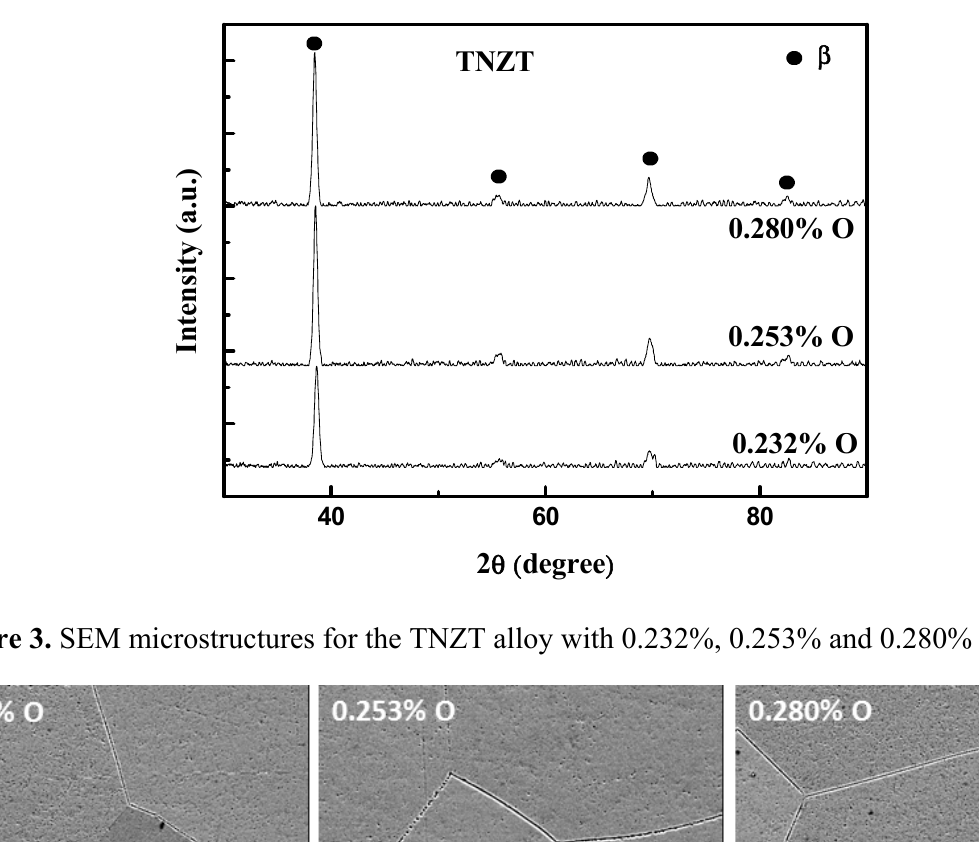
Figure 2. XRD patterns for the TNZT alloy with 0.232%, 0.253% and 0.280% of oxygen.